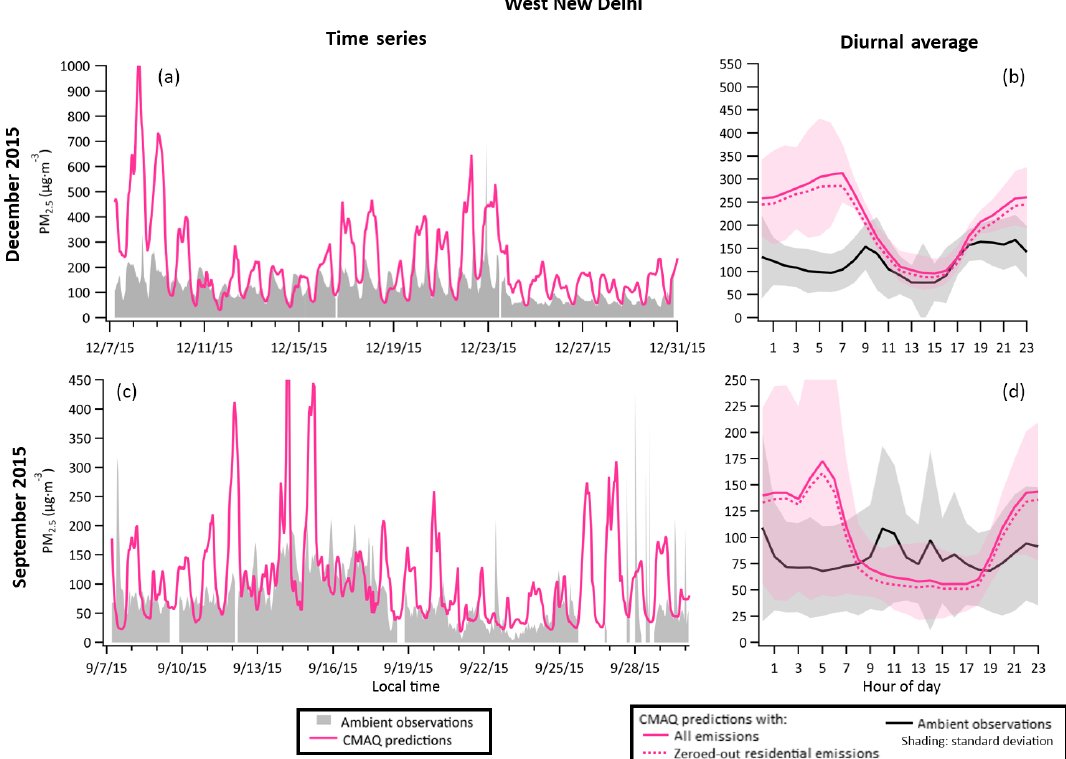
Figure 8. Measured and predicted PM 2 . 5 (a, c) and average diurnal cycle (b, d) in West New Delhi for 20–31 December 2015 (a, b) and 20–30 September 2016 (c, d) . Here the pink lines correspond to CMAQ predictions of the “total” (solid) and “nonresidential” (dotted) simu- lations. The solid black line represents ambient observations. Standard deviations of the diurnal profiles for observations and predictions are indicated by gray and pink colored shading, respectively. Diurnal profiles were averaged over simulation durations (Table 7). Computations were carried out at 4km